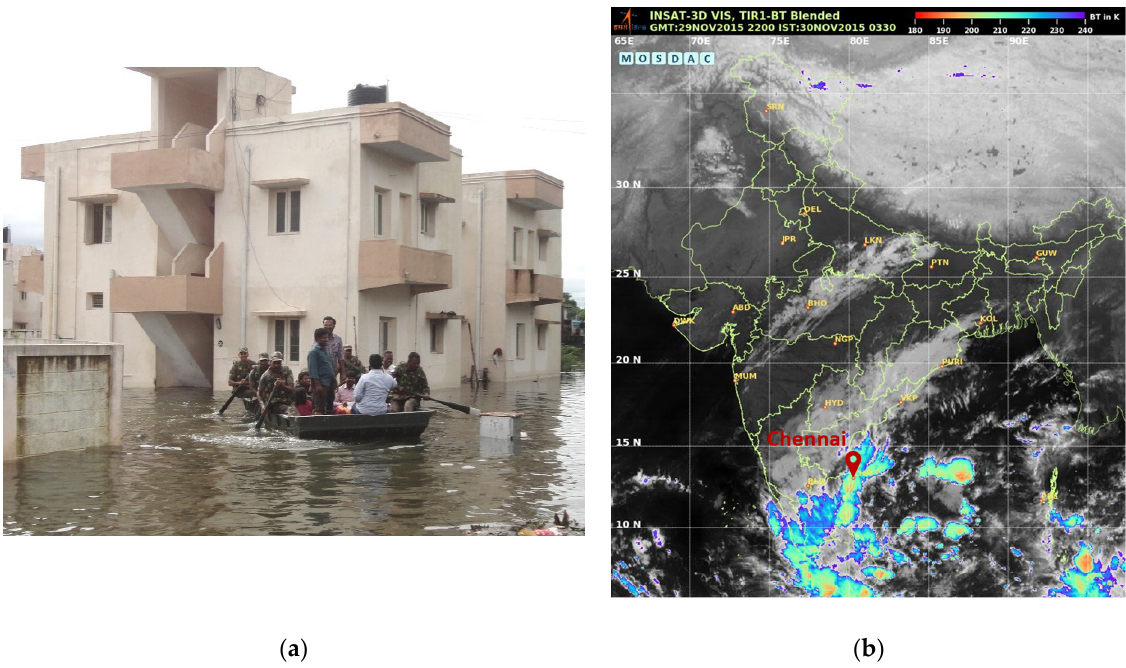
Figure 1. ( a ) Submerged regions in Chennai during the heavy rainfall event in December 2015. Source: https://commons.wikimedia.org/wiki/File:Army_flood_relief_and_rescue_operations,_in_Chennai_on_November_17,_2015_(3).jpg (accessed on 15 December 2021). Licensed under CC BY-SA. ( b ) Cloud cover over the southern region of India on 1 December 2015 0130. Note the extensive cloud coverage over Chennai (13.0827° N, 80.2707° E).